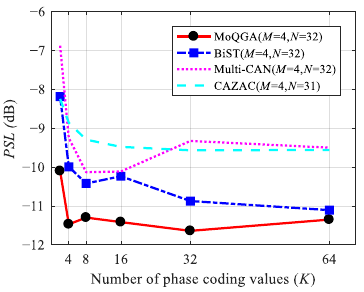
Figure 14. PSL values of MIMO radar poly-phase code sequence set obtained by MoQGA and other methods when M = 4 and N =